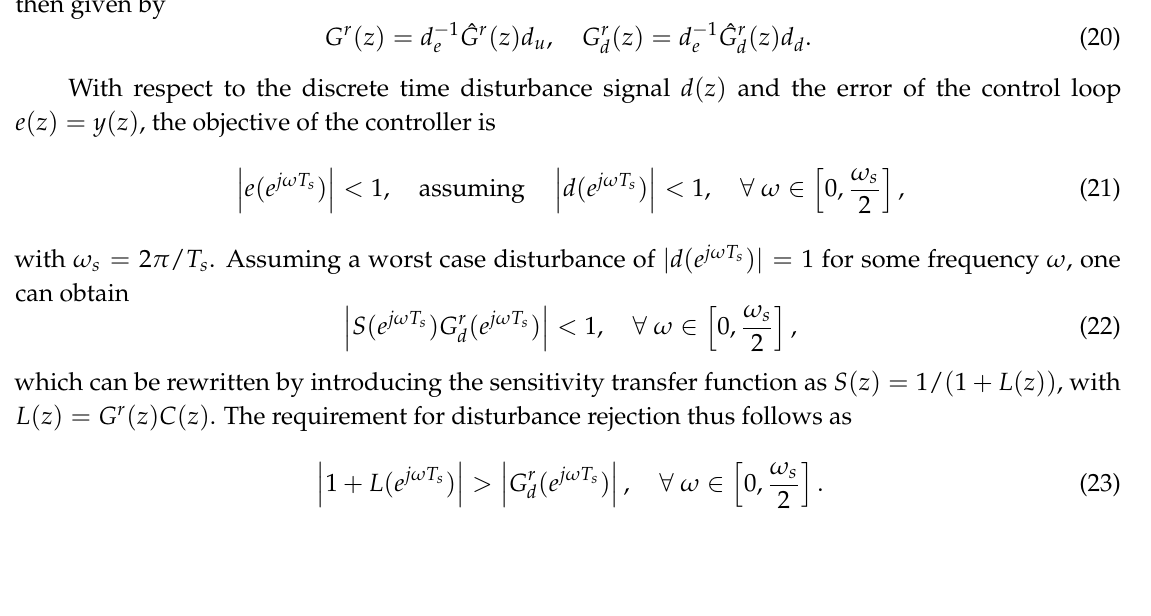
ˆ G r ( z and ˆ G r ( z ) d